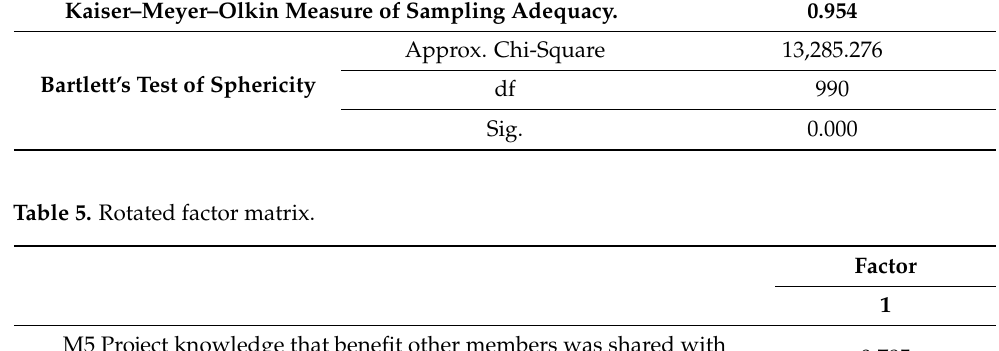
Table 4. KMO and Bartlett’s test.